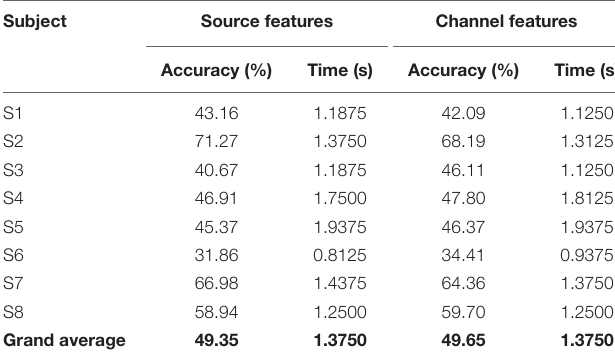
TABLE 1 | Peak performance of using source features and channel features and their corresponding time